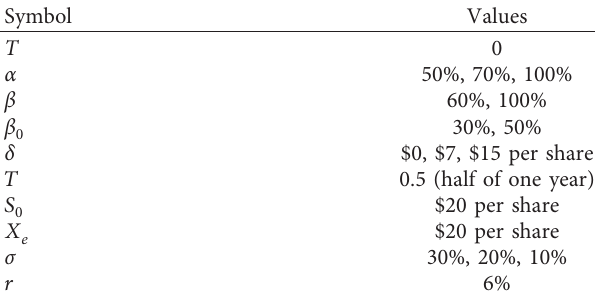
Table 1: Calculation